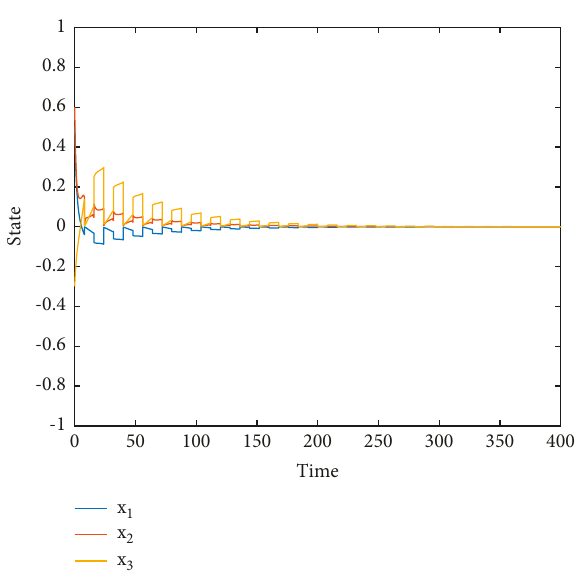
Figure 7: The state of (43) under hybrid impulsive control